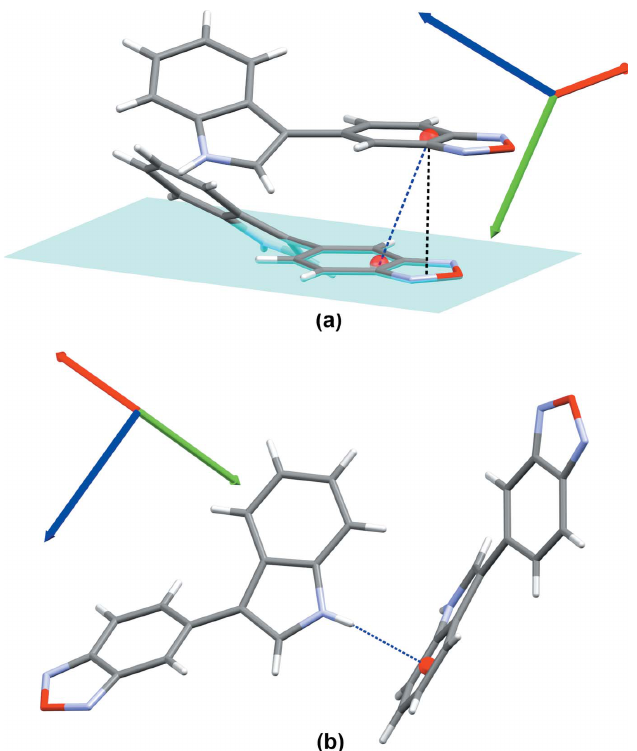
Figure 6 Supramolecular organization of bO. ( a ) (cid:2) -stacking interaction between the benzoxadiazole groups and ( b ) N—H (cid:6)(cid:6)(cid:6) (cid:2) interaction between two indole groups